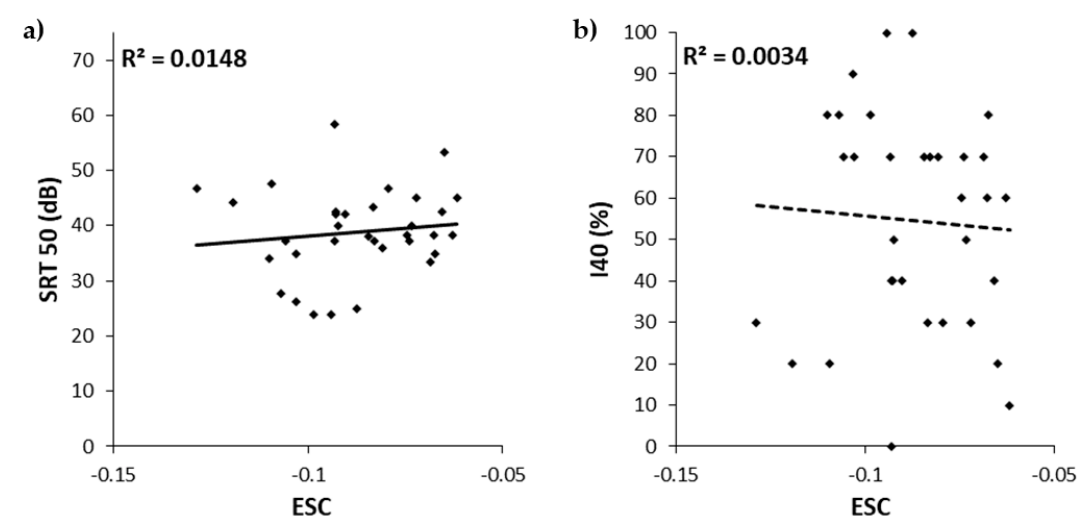
Figure 4. Scatter plots of the 50% speech reception threshold (SRT50, ( a )) and the intelligibility at 40 dB (I40, ( b )) as a function of the exponential spread coefficient (ESC) for all 33 participants. Bravais-Pearson determination coefficients are indicated in the upper left corner.